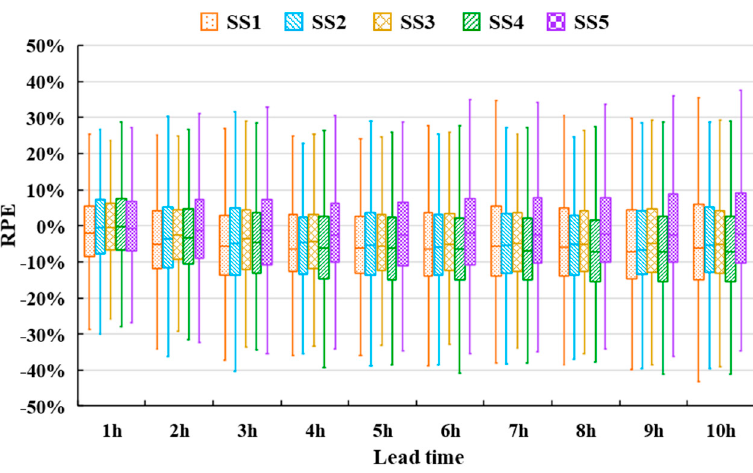
Figure 11. Relative Peak ‐ Discharge Error (RPE) for different sample sets at 1–10 ‐ h lead ‐ time.